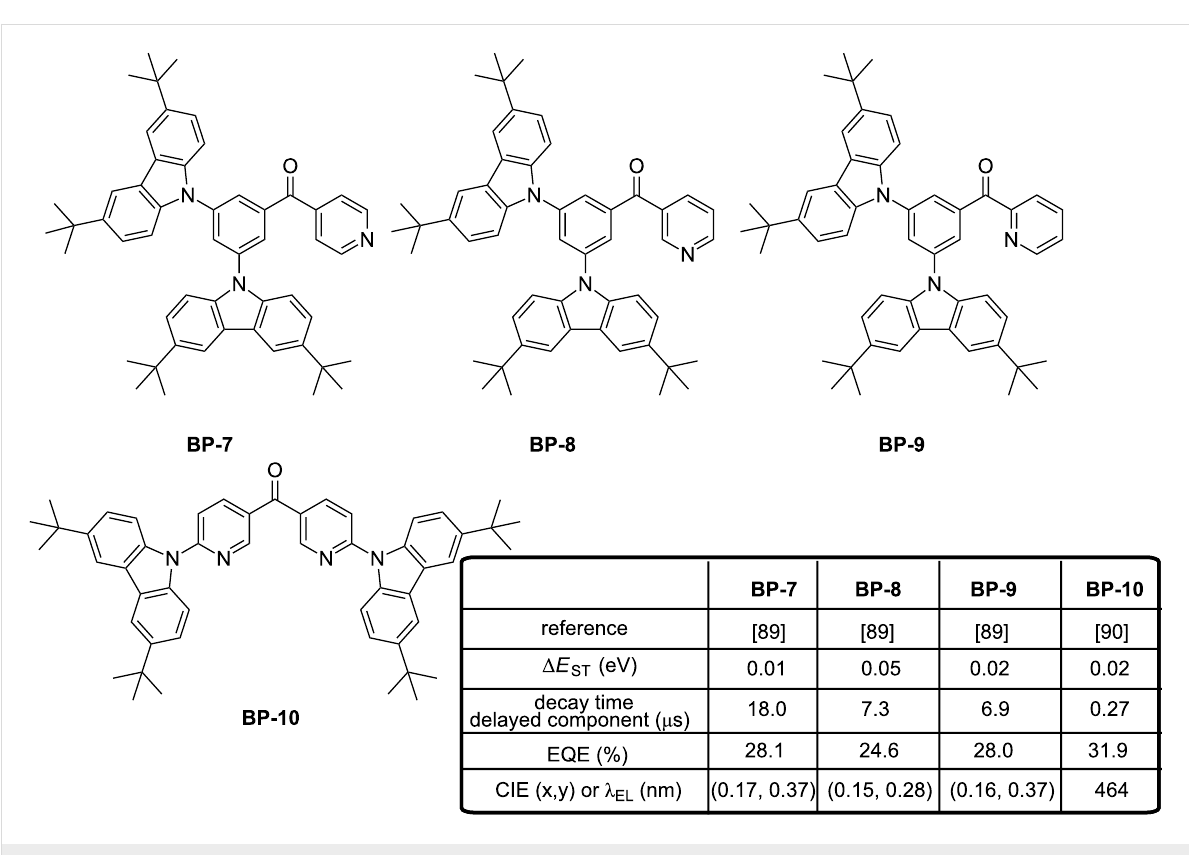
Figure 18: Benzoylpyridine-carbazole hybrid emitters BP-7 – BP-10